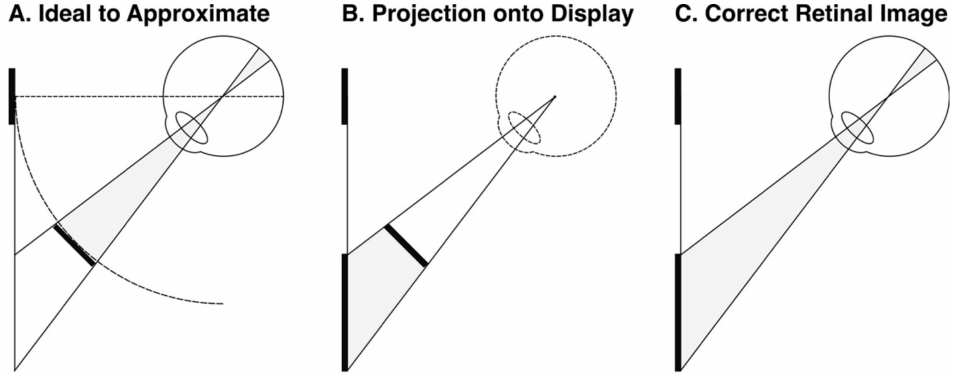
Figure 5. OpenGL rendering of target achieves the correct retinal image for a target with a constant radius and orientation to the eye, whilst presenting the target on a fronto-parallel